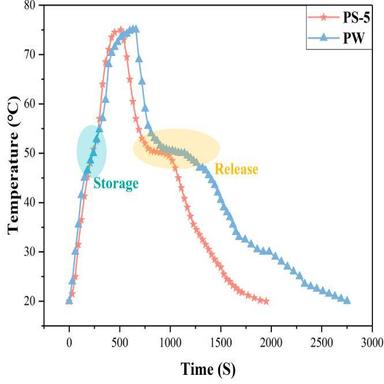
Temperature-time curves of PW and PS-5.